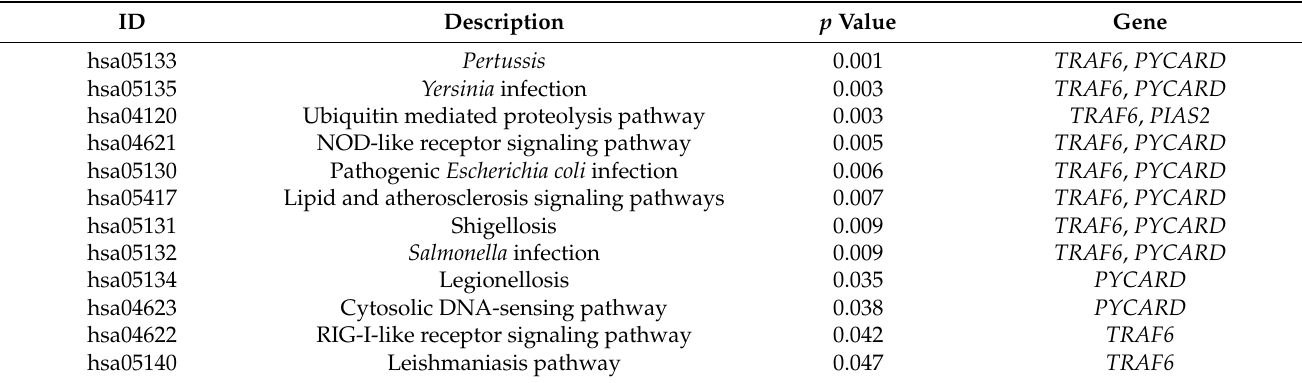
Table 3. KEGG enrichment analysis.